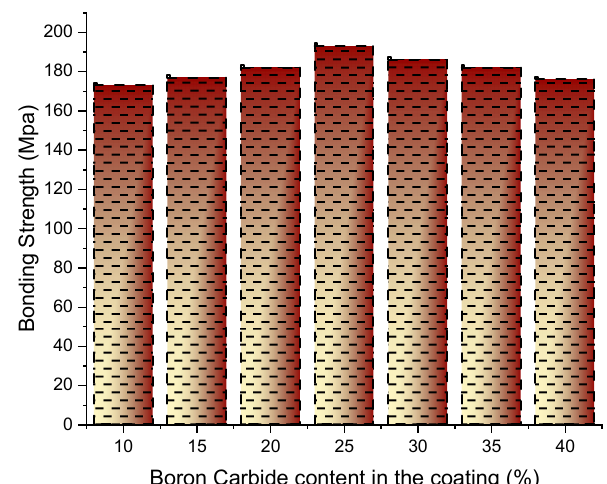
Figure 5. The bonding strength of different B 4 C/Ni63 coatings. Figure 5. T he bonding strength of different B 4 C /Ni63 coatings.